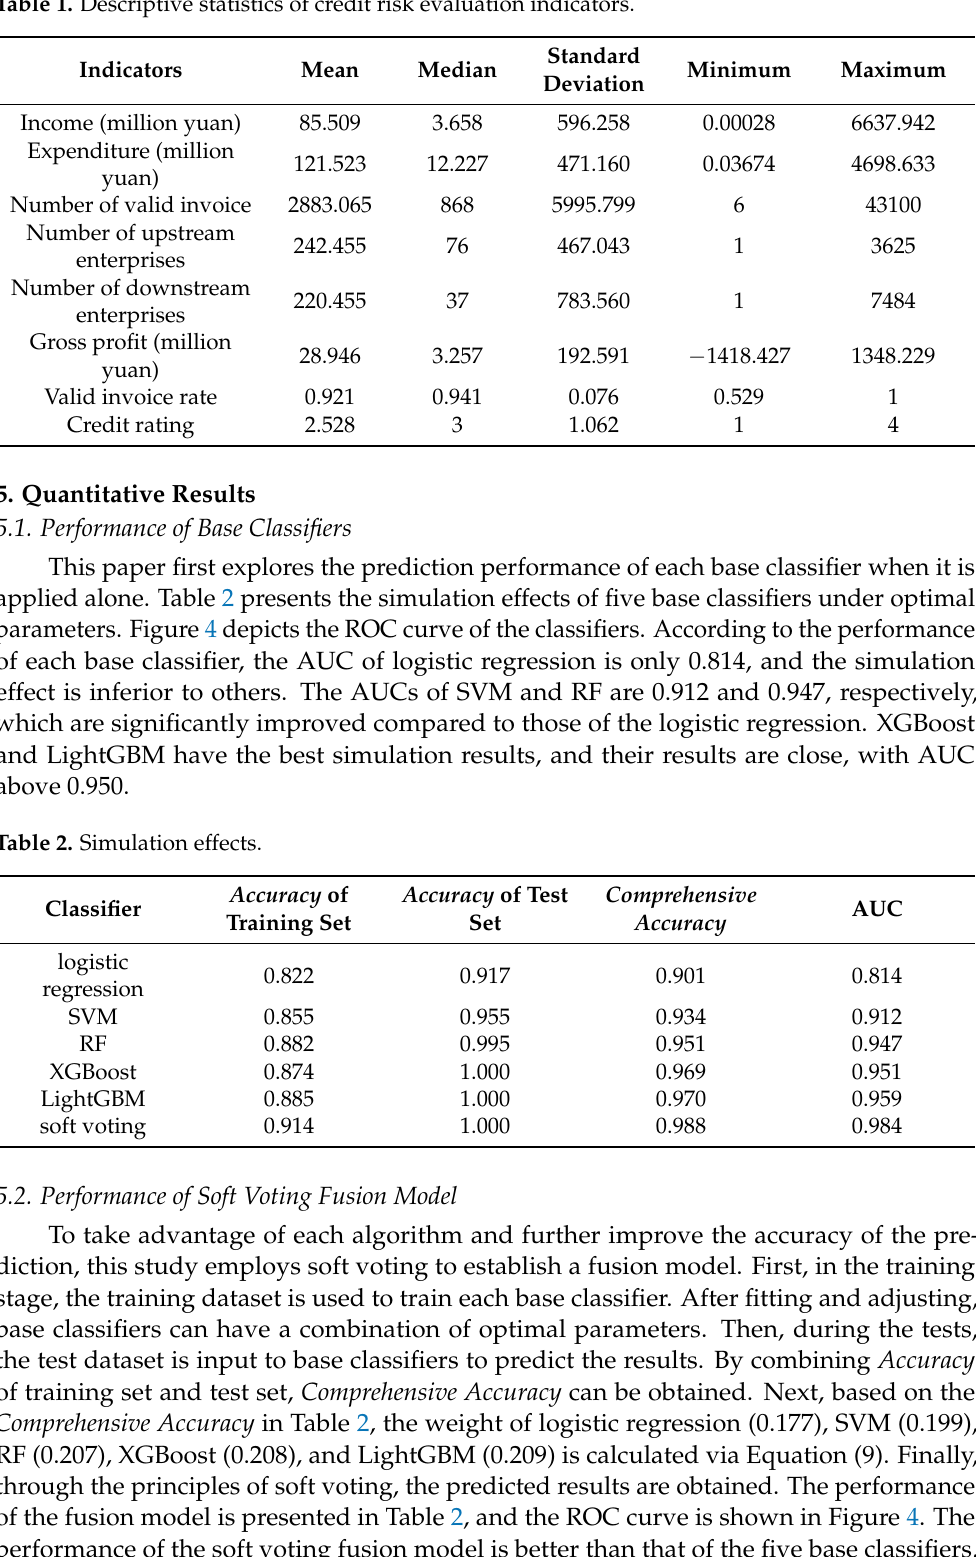
Table 1. Descriptive statistics of credit risk evaluation indicators.